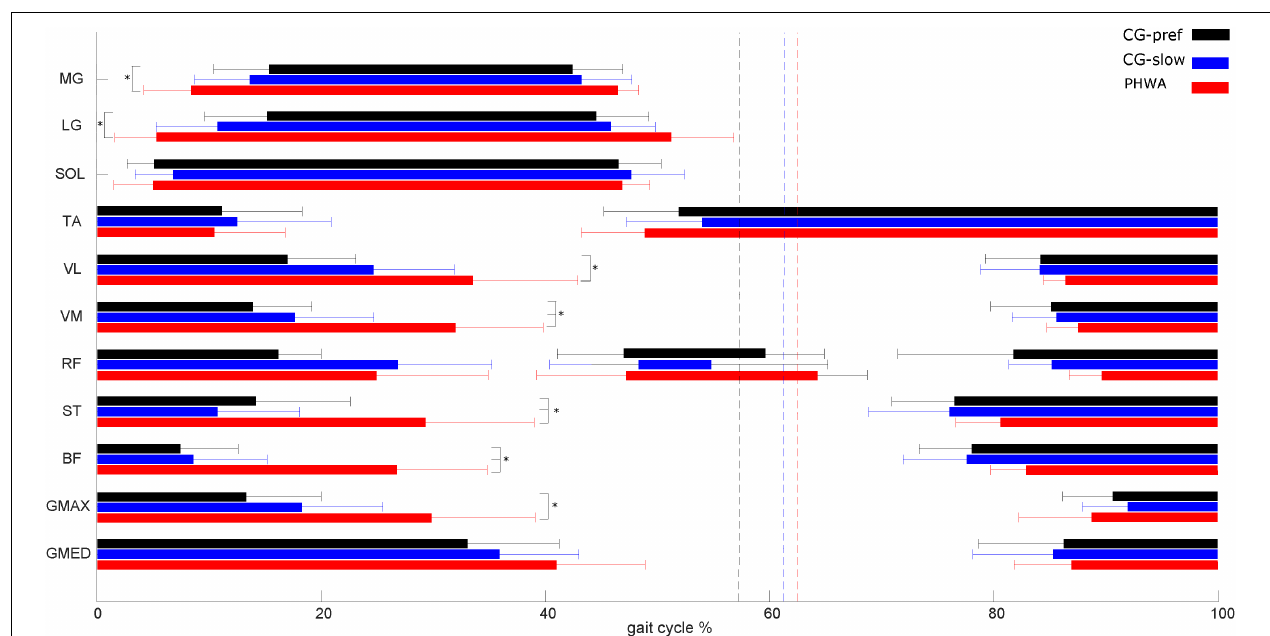
FIGURE 7 | Electromyography (EMG) burst on- and offset during gait. EMG burst on- and offset during gait of people with hemophilic arthropathy (PWHA; n = 14) at their preferred velocity (red), the control group ( n = 13) at their preferred velocity (CG-pref, black), and during the slow velocity condition (CG-slow, blue). The second burst of rectus femoris muscle during stance to swing transition was present in only part of the subjects: 11/13 for the CG-pref, 6/13 for CG-slow, and 9/14 in PWHA. Data are plotted as a function of normalized step time (0, heel strike) and expressed as mean with 95% confidence interval for CG. Vertical dashed lines indicate transition from stance to swing phase (black, CG-pref; blue, CG-slow; red, PWHA). Medial gastrocnemius (MG), lateral gastrocnemius (LG), soleus (SOL), tibialis anterior (TA), vastus lateralis (VL), vastus medialis (VM), rectus femoris (RF), semitendinosus (ST), biceps femoris (BF), gluteus maximus (GMAX), and gluteus medius (GMED). Data are expressed as mean and 95% confidence interval.